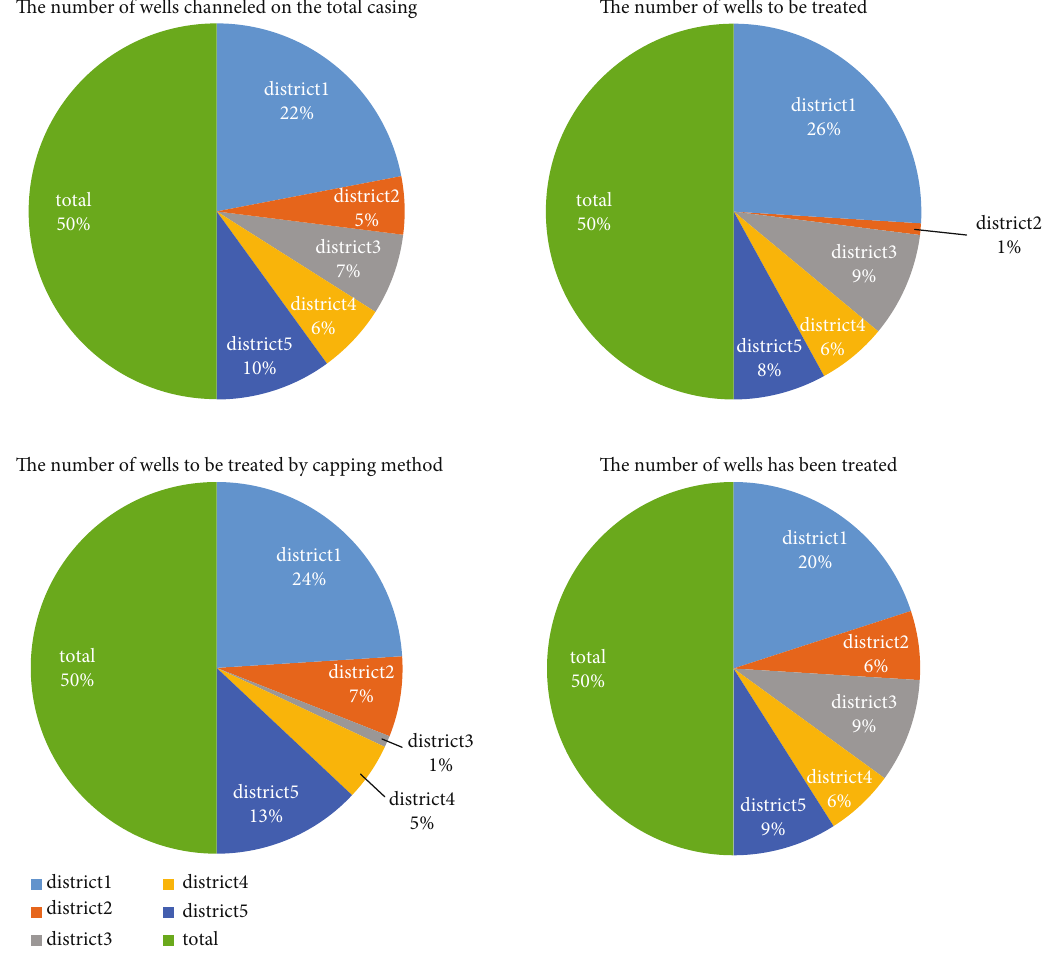
Figure 2: Statistical chart of casing moving up and treatment results in Jidong Oil fi